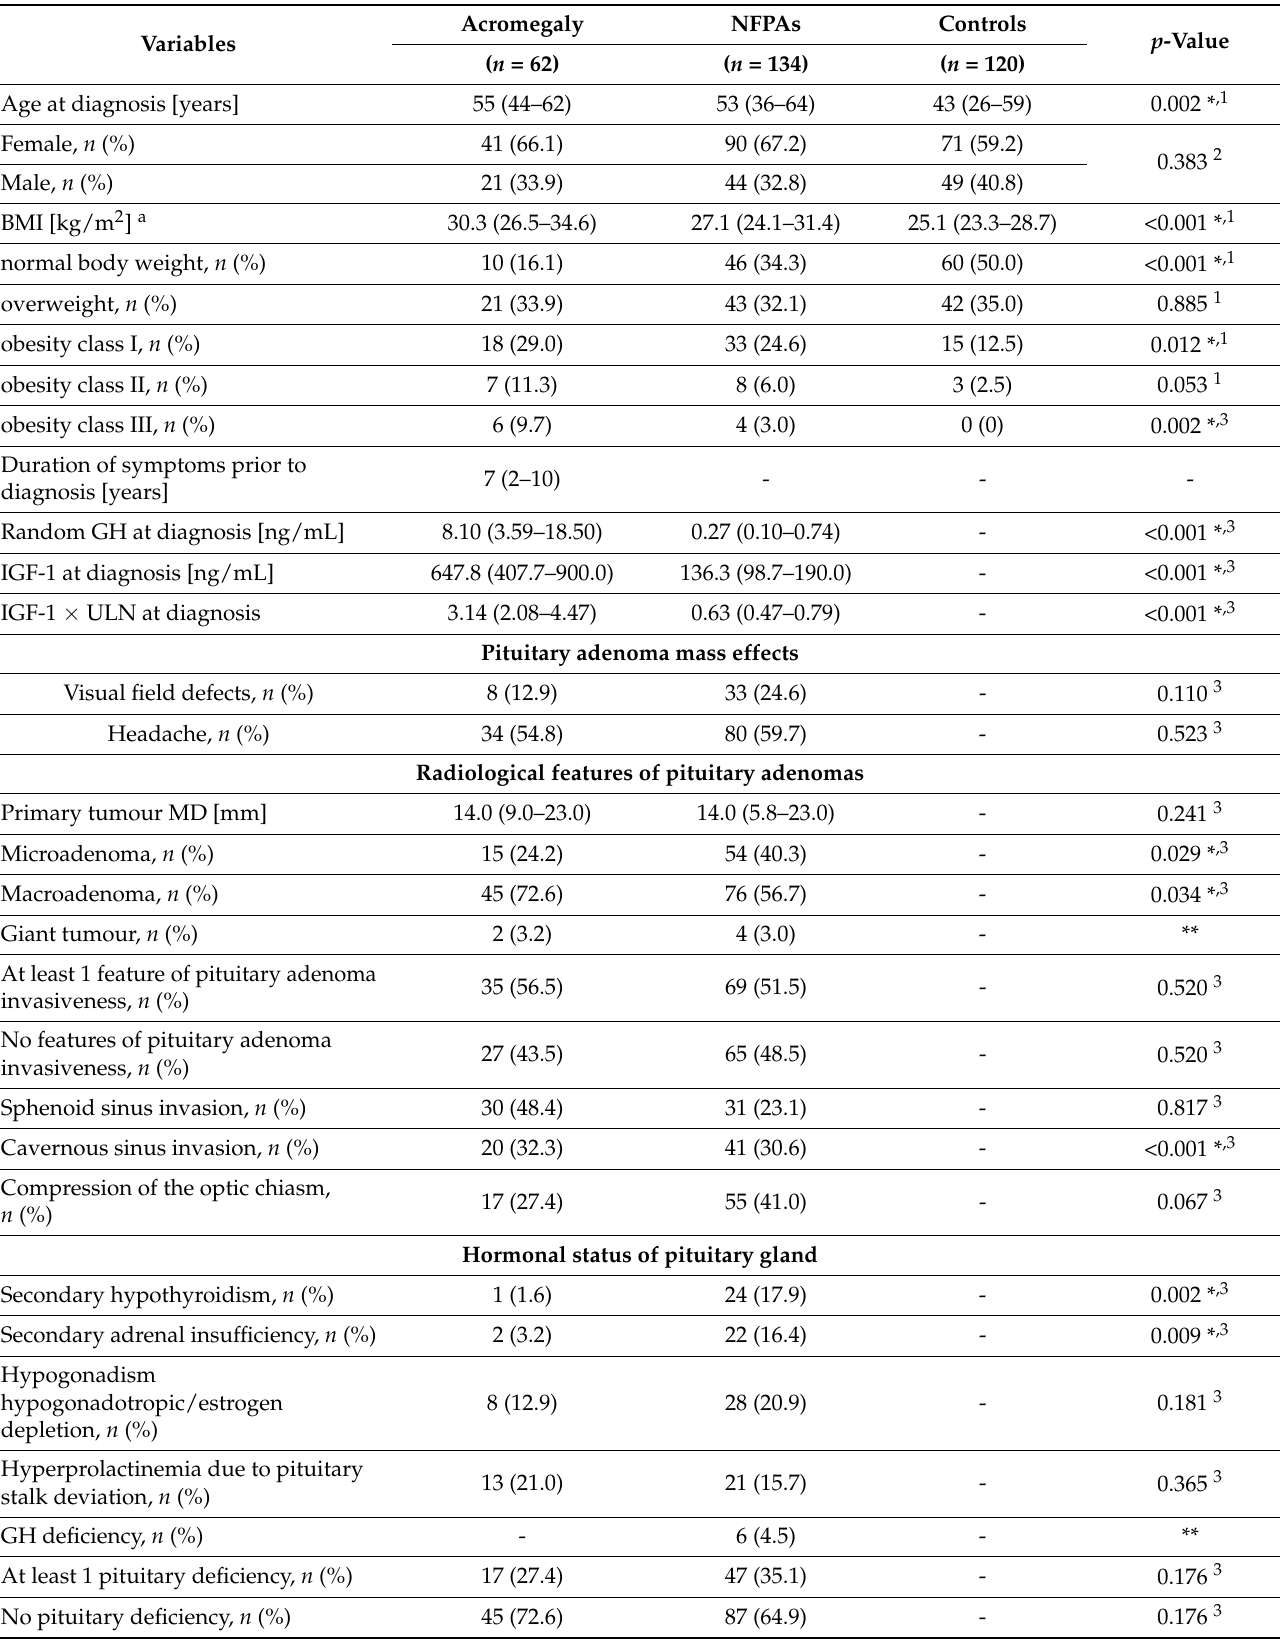
Table 1. General characteristics of the study and control